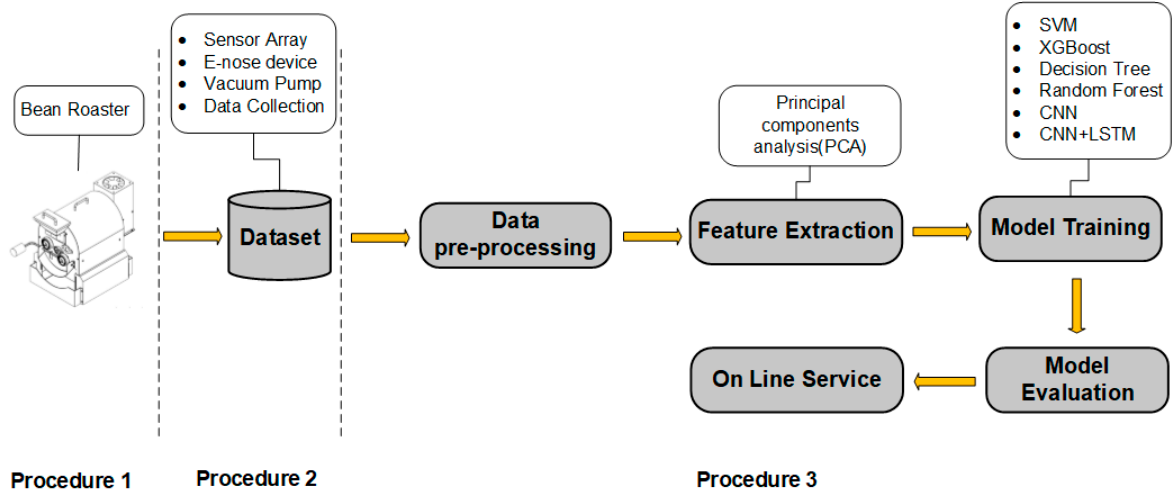
Figure 2. Research workflow and experimental process.